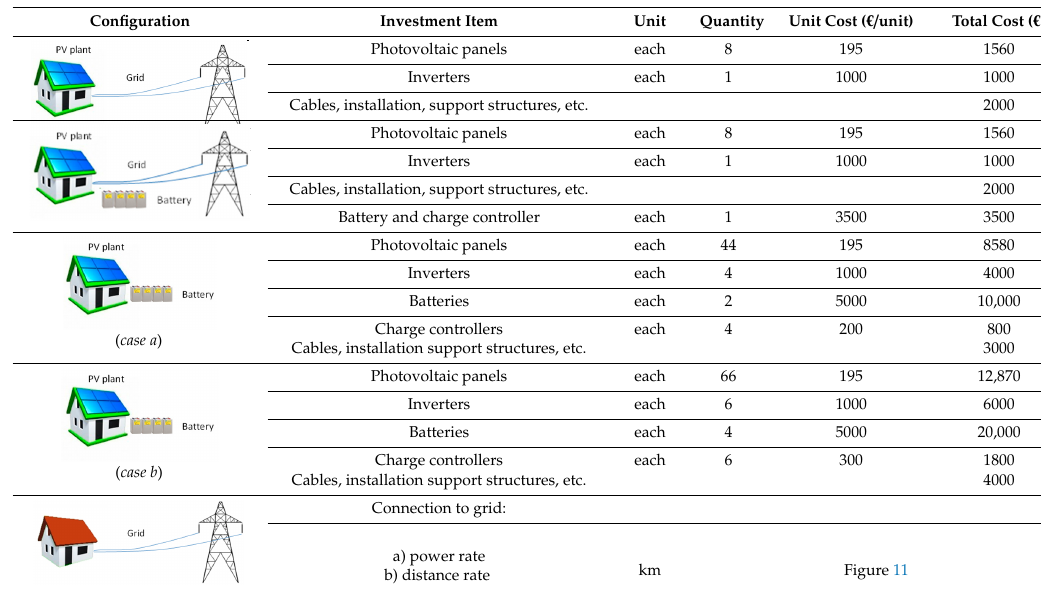
Table 3. Investment costs.